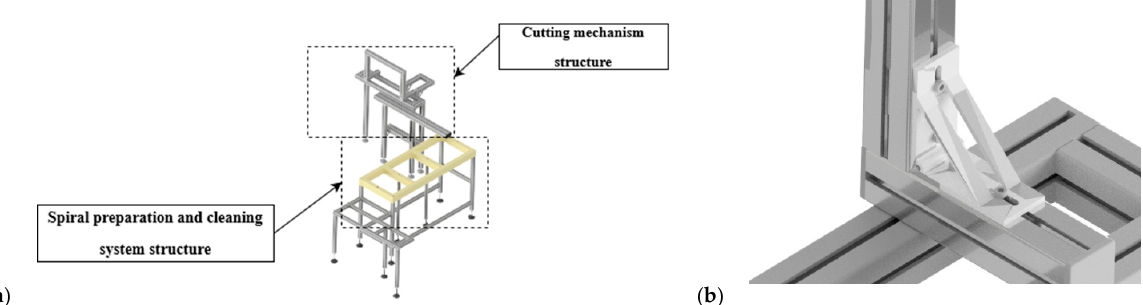
Figure 21. Machine structure ( a ) and corner connections ( b ).